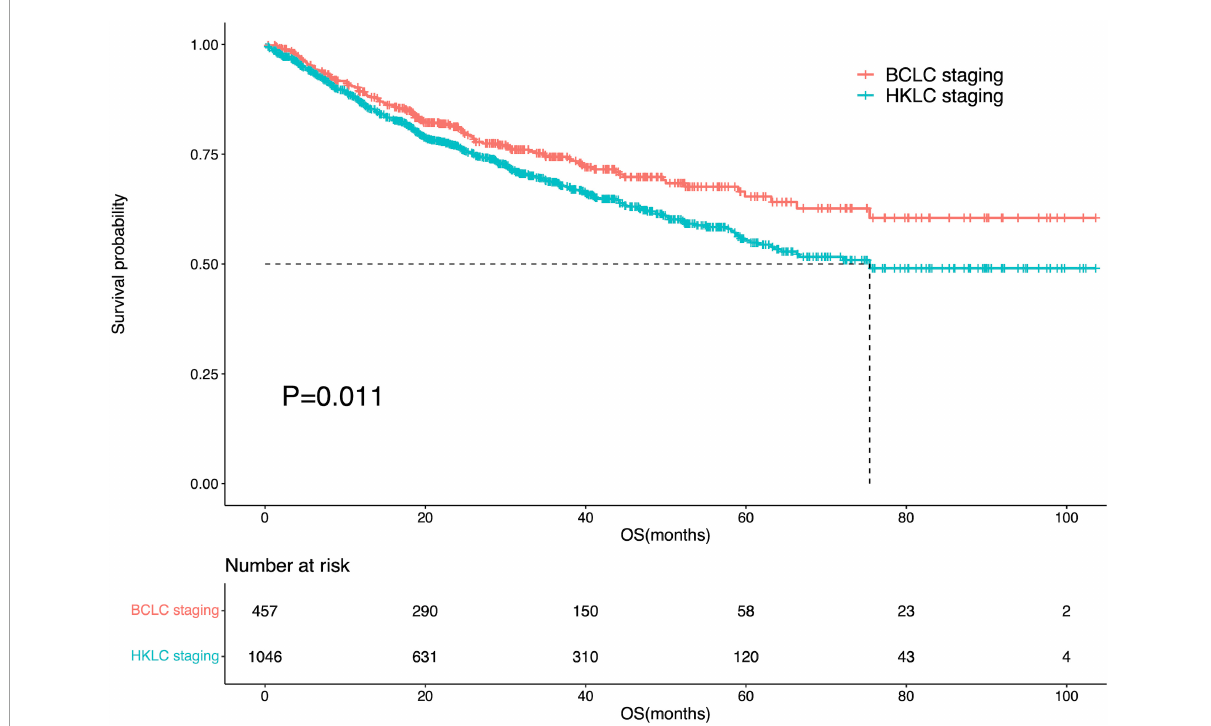
FIGURE3 Survival curve of the IPLRs in the BCLC staging system and those in the HKLC staging system.